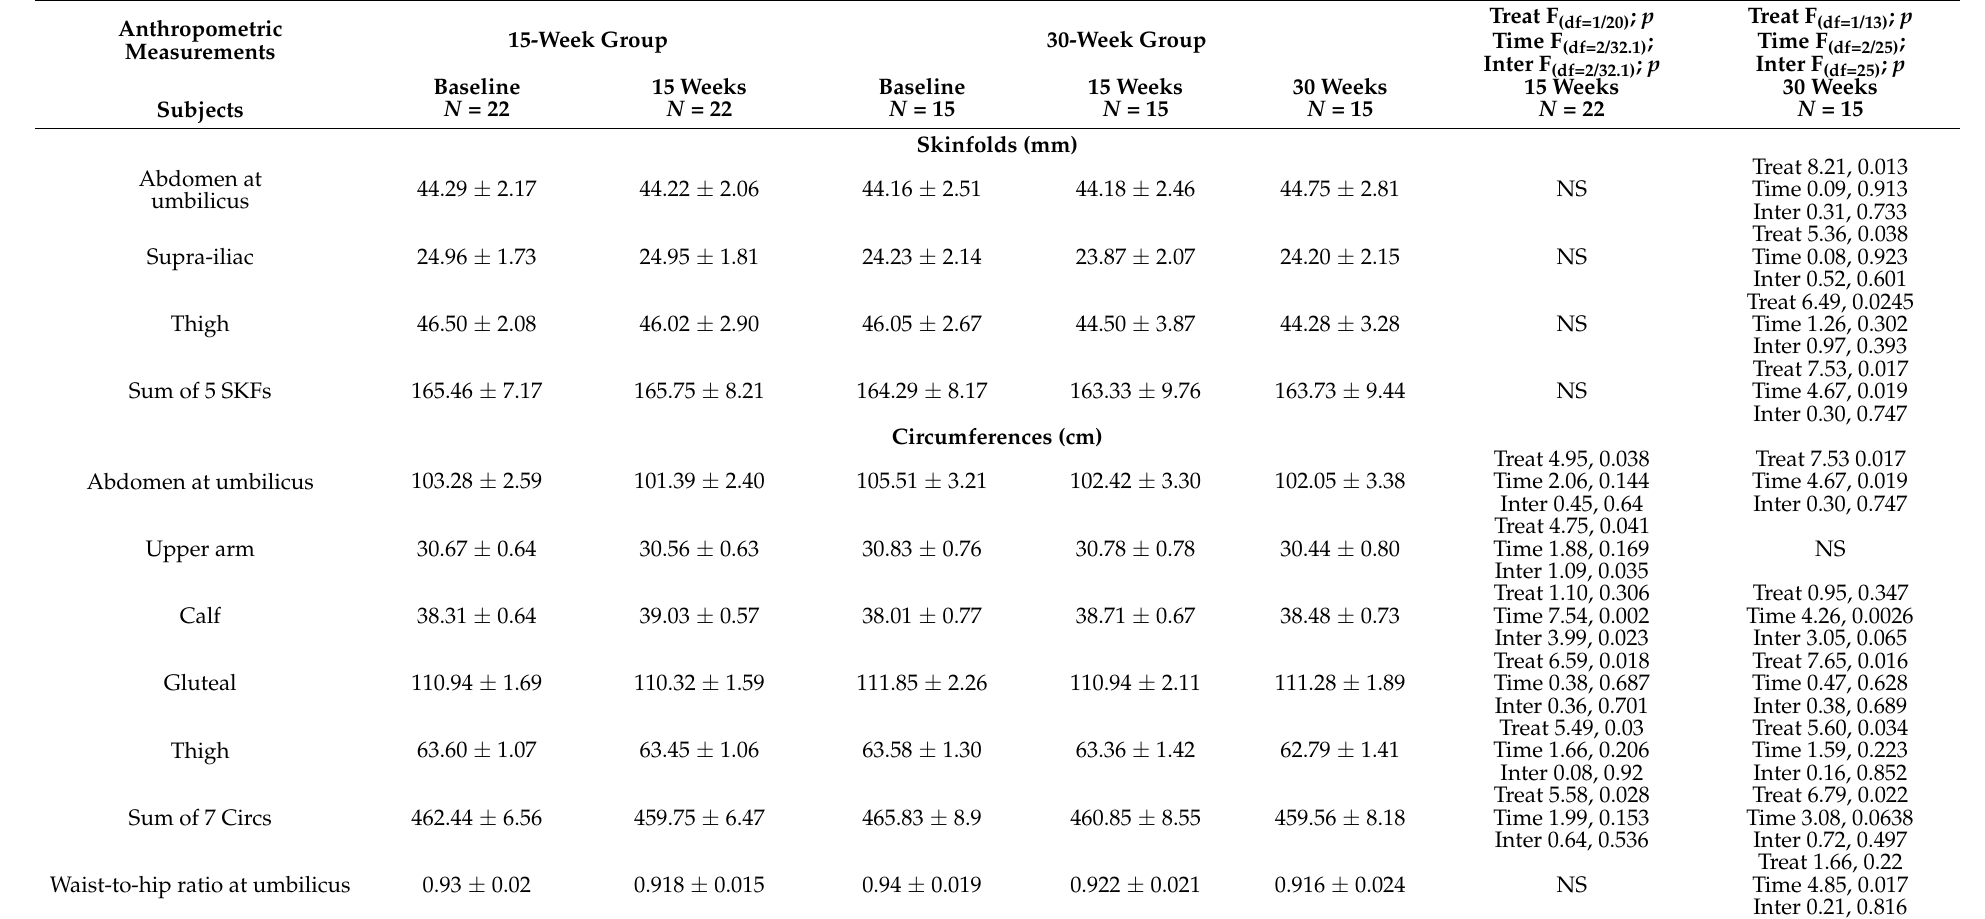
Table 5. Effects of 15 and 30 weeks of walking, independent of speed, on anthropometric measurements of abdominal and peripheral skinfolds and